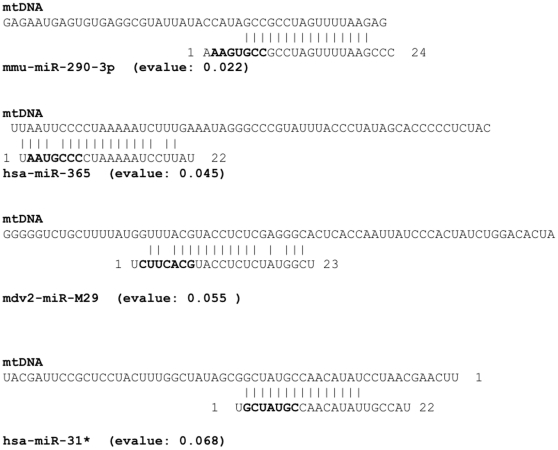
Examples of alignment results of human mature miRNA 365 and 31.The nucleotides in bold letters indicate the seed region of the miRNA.